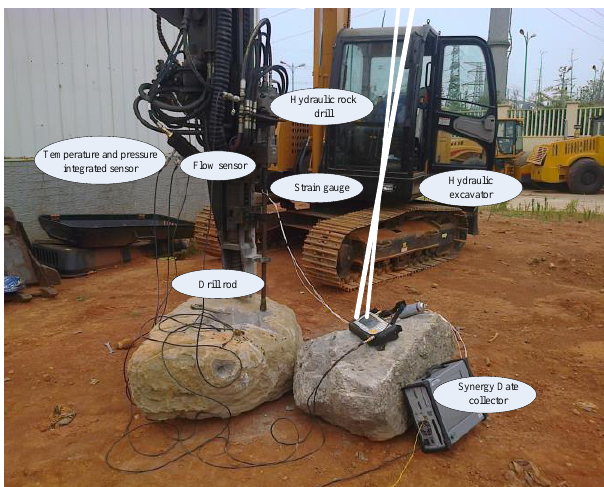
Figure 6. Testing system of YG45 impactor.